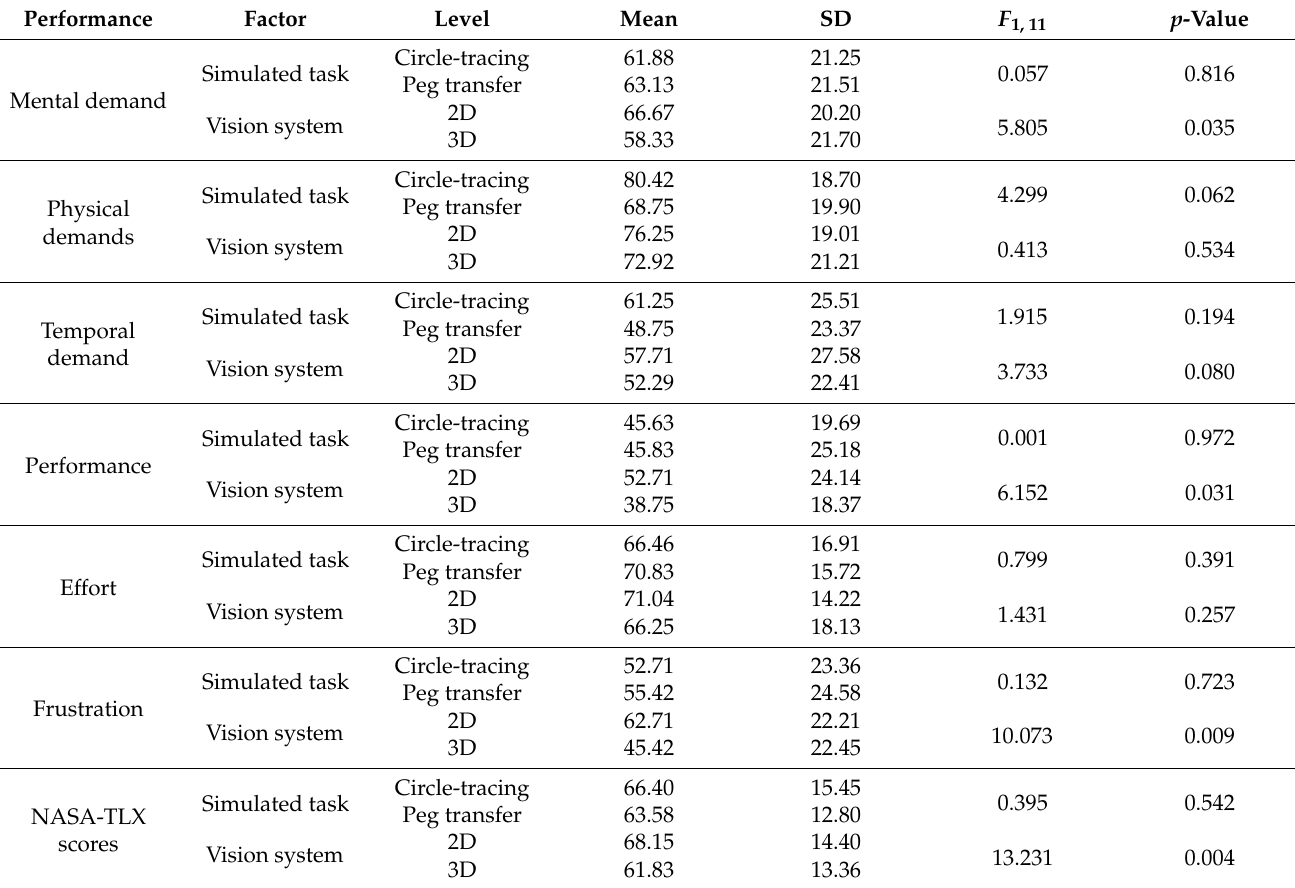
Table 1. Means, standard deviations (SDs), and Analysis of Variance (ANOVA) results of National Aeronautics and Space Administration Task Load Index (NASA-TLX) for the simulated task and vision